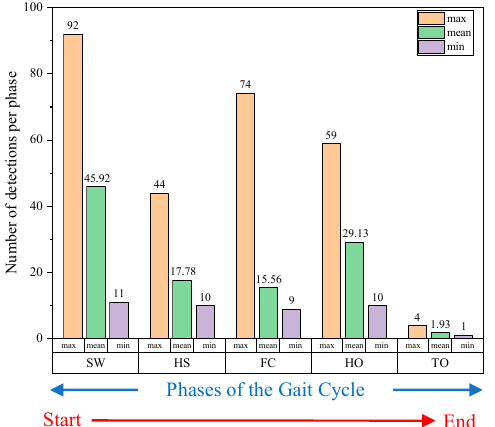
Figure 6. Results of the feasibility study in terms of numbers of the maximum, minimum, and average detections per sub-phase.